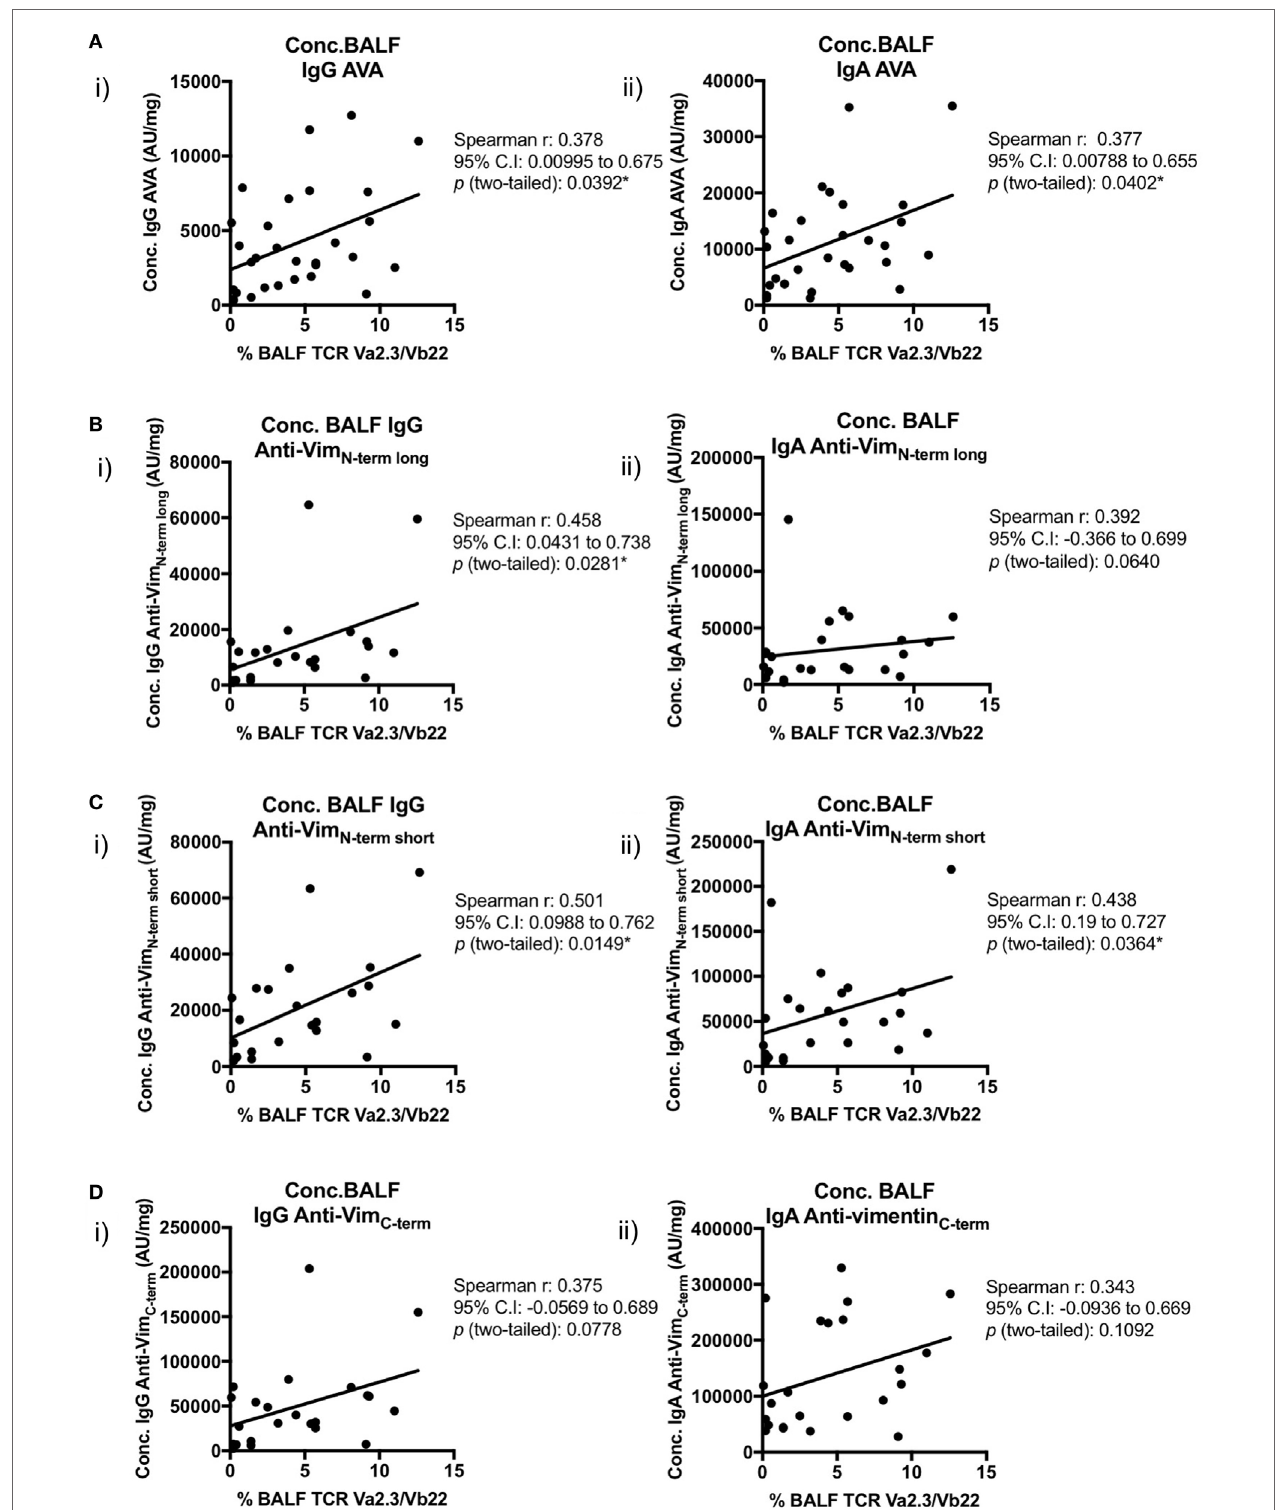
FigUre 8 | Association of V α 2.3 + V β 22 + CD4 + T-cells in bronchoalveolar lavage fluid (BALF) with antibodies to different vimentin truncations. Spearman’s correlations between (combined HLA-DRB1*03 + and HLA-DRB1*03 − ) patient-matched BALF V α 2.3 + V β 22 + CD4 + T-cell percentage (of total CD4 + T-cells; as determined by flow cytometry) and BALF antibody concentrations (Arbitrary units/mg) to full-length (anti-vimentin antibodies) (a) and truncated vimentin (B–D) for both IgG (i) and IgA (ii). Lines of best-fit are